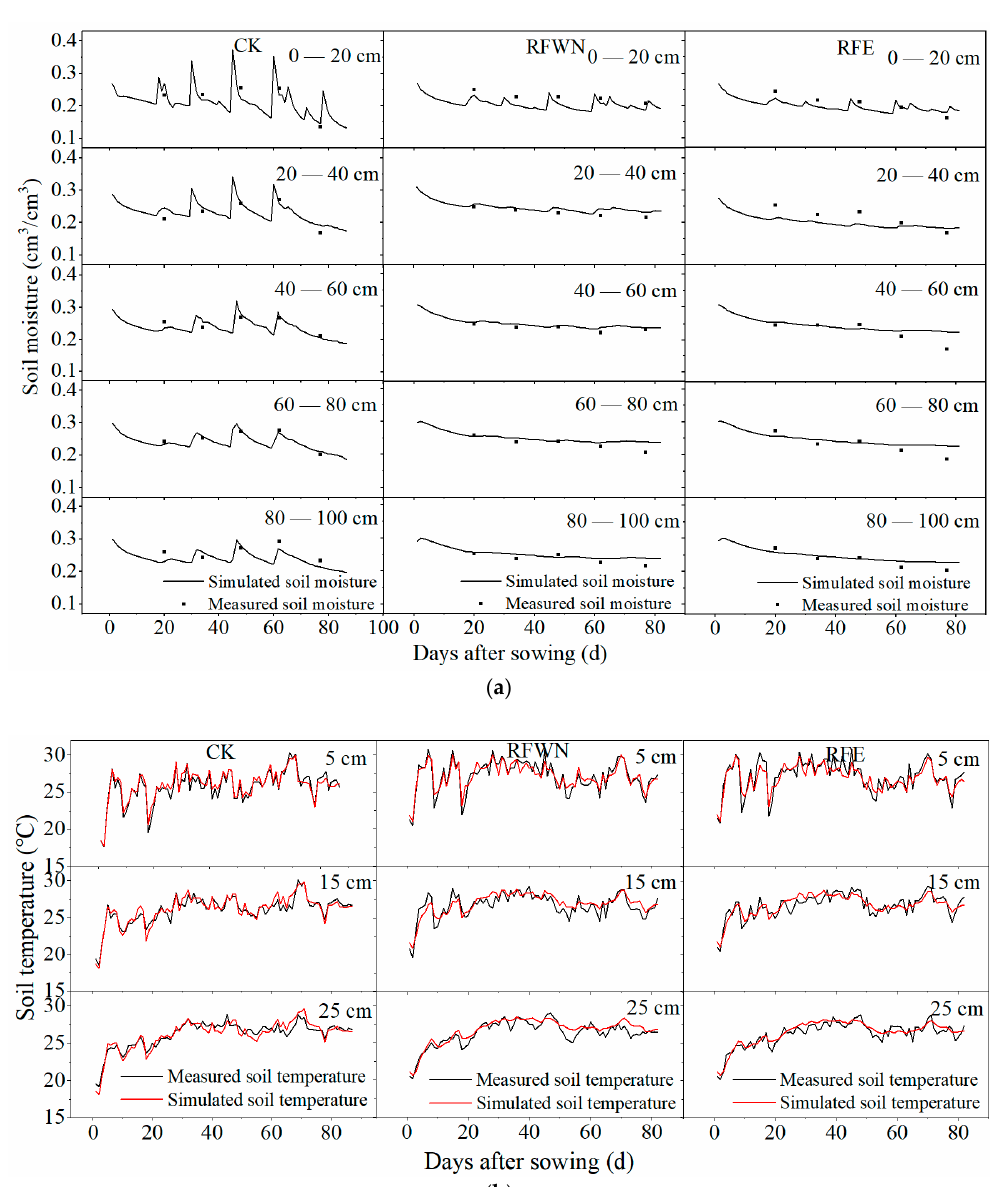
Figure 7. Dynamic changes in soil water and heat. ( a ) Soil water dynamic change; ( b ) Soil temperature change.